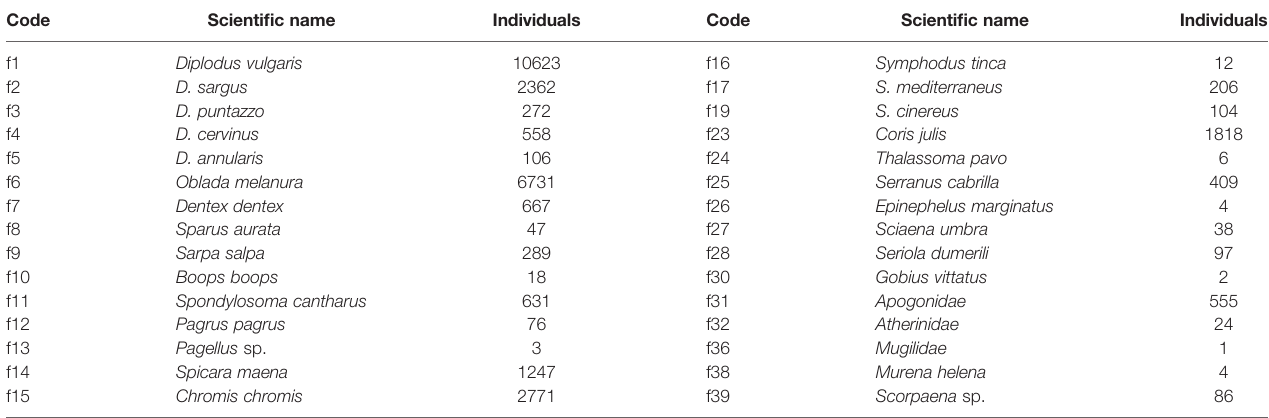
TABLE 1 | Species expected and observed in the OBSEA site: list by scienti fi c names and the number of observed individuals.